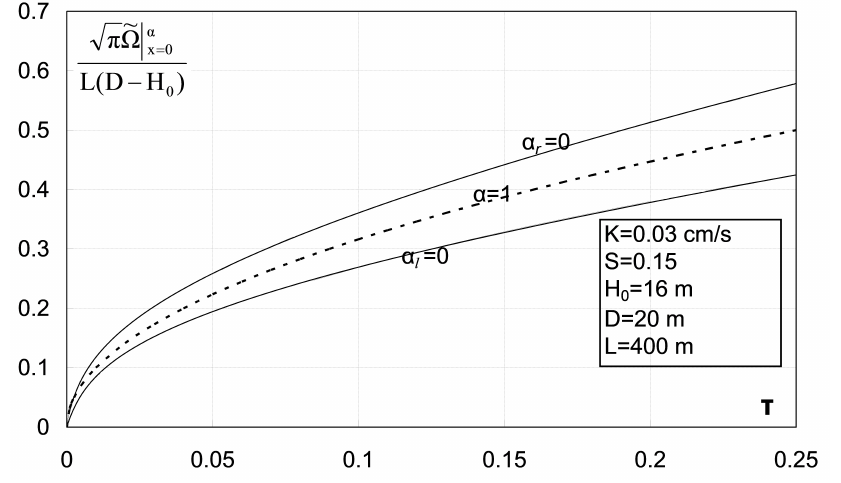
Figure 10. Recharging water volume at x = 0.